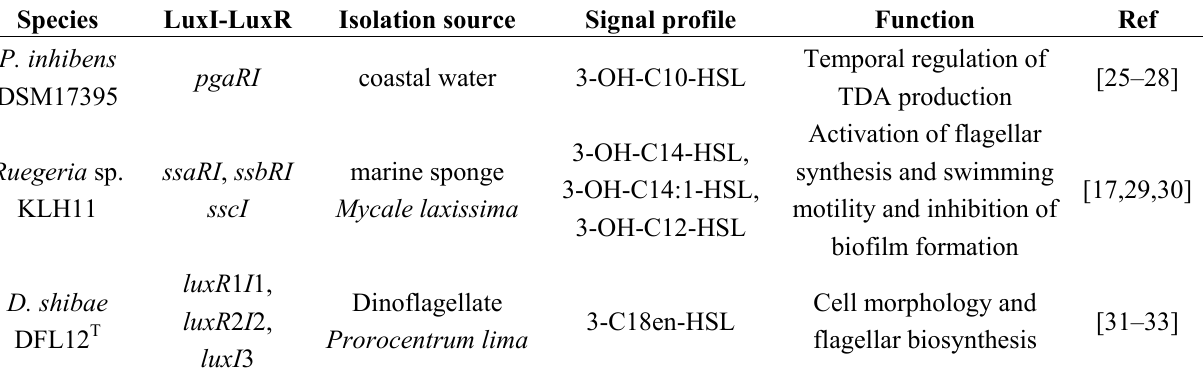
Table 1. Summary of the three roseobacterial species